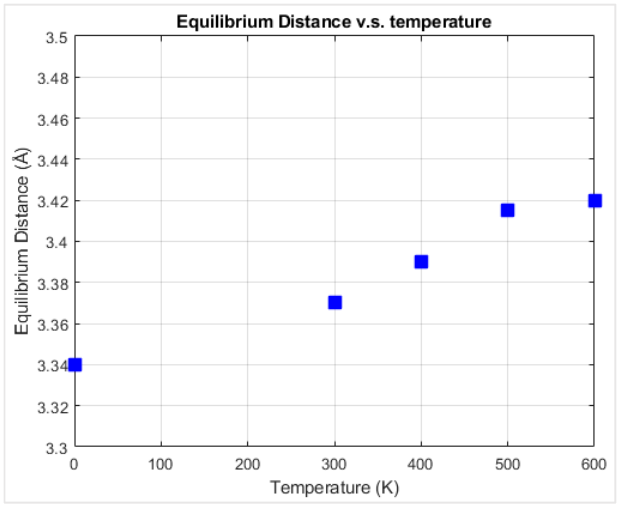
Figure 6. Thermodynamic equilibrium interlayer distance between the diamond substrate and the graphene nanoflake versus temperature.